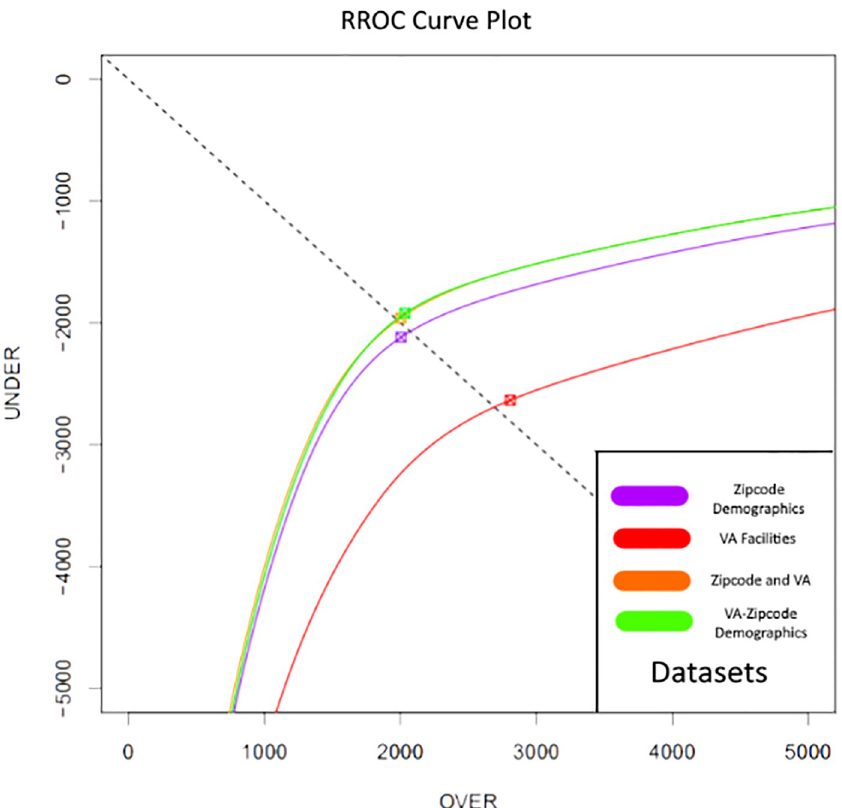
Fig 1. RROC curve for XGBoost model trained on each dataset. Notes.—The figure plots the RROC curve for XGBoost Models trained on 4 datasets. The Zipcode Demographics Dataset features contain only zipcode level demographic data. The VA Facility Dataset contains features only pertaining to the access and quality of care of the closest local and large regional VA Medical Centers. The Zipcode and VA Dataset contains all of the features from the first two datasets. The VA-Zipcode Interaction Dataset includes all features from the third dataset and new feature columns that interact each feature related to VA facility access and quality of care with each demographic level zipcode feature. RROC plots visualize the relative accuracy of regression models as well as indicating bias in the model by plotting with respect to over and under estimation of predictions [29].